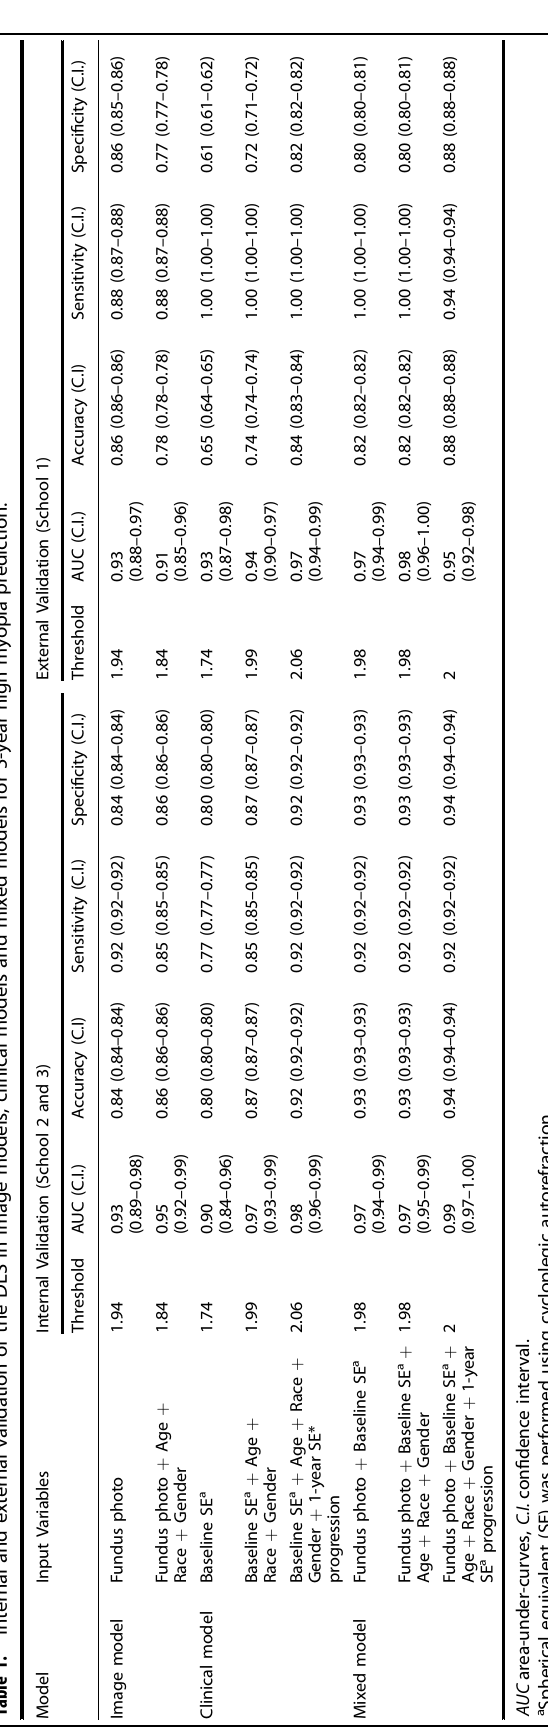
algorithm for image models, clinical models and mixed